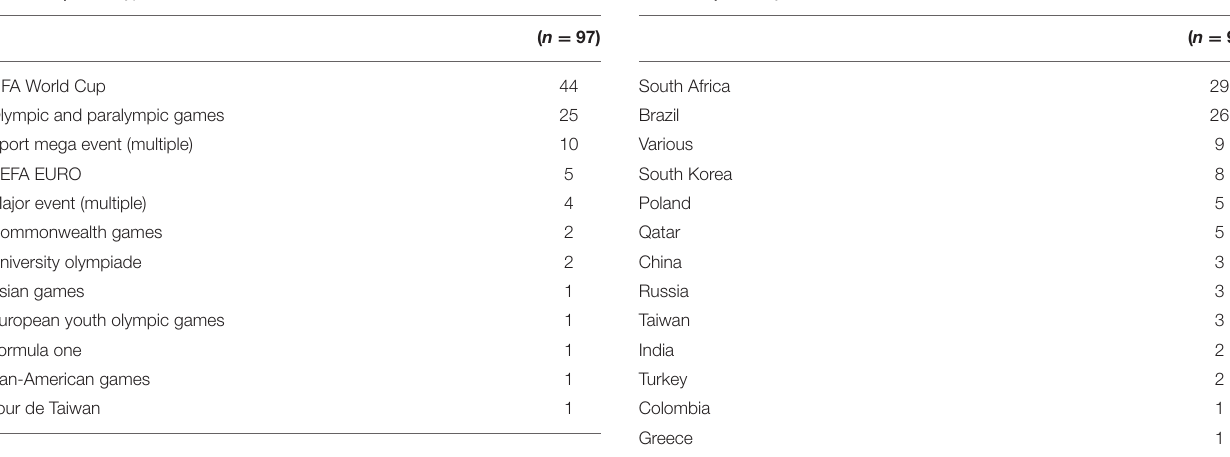
TABLE 1 | Event type. TABLE 2 | Country